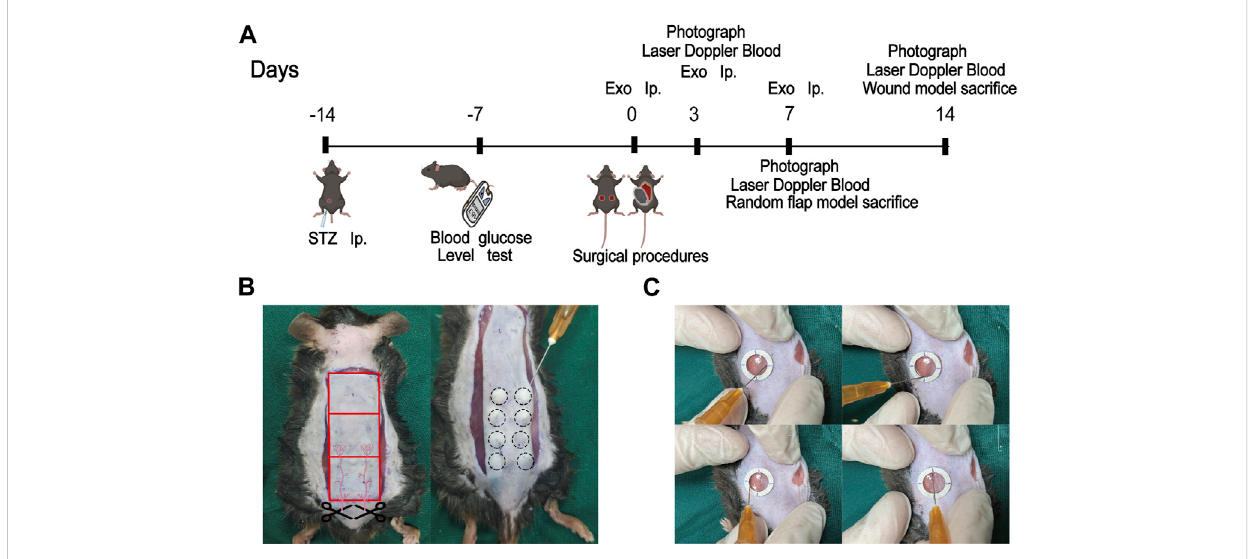
FIGURE 3 Schematic framework and animal surgery representative images. (A) The schematic framework of the animal experimental design; (B) The gross image of the construction of the random fl ap model (left) and the treatment of miR-132-exo on mice diabetic fl ap model (right); (C) The treatment of miR-132-exo on mice diabetic wound